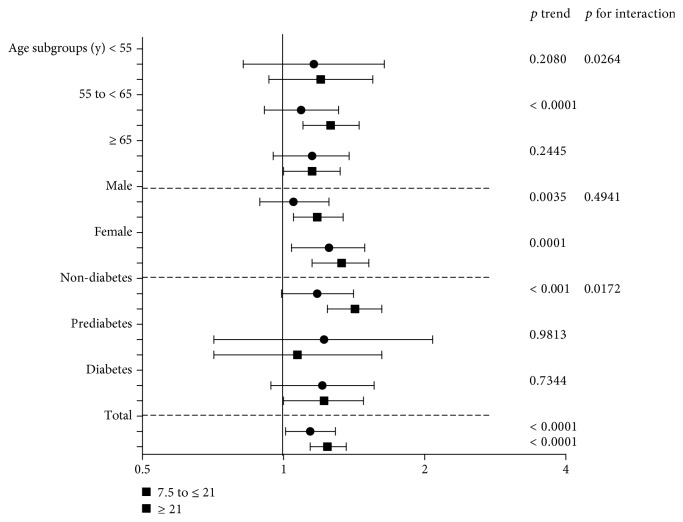
Odds ratios for logistic regression model II of the association between duration of walking quartiles and eGFR category (model II adjusted for age, gender, BMI, region, education level, SBP, DBP, pulse, LDL, HDL, TG, FBG, PBG, HbA1c, smoking status, drinking status, history of hypertension, cardiovascular disease history, diabetes history, medication history, diabetes family history, and hypertension family history).